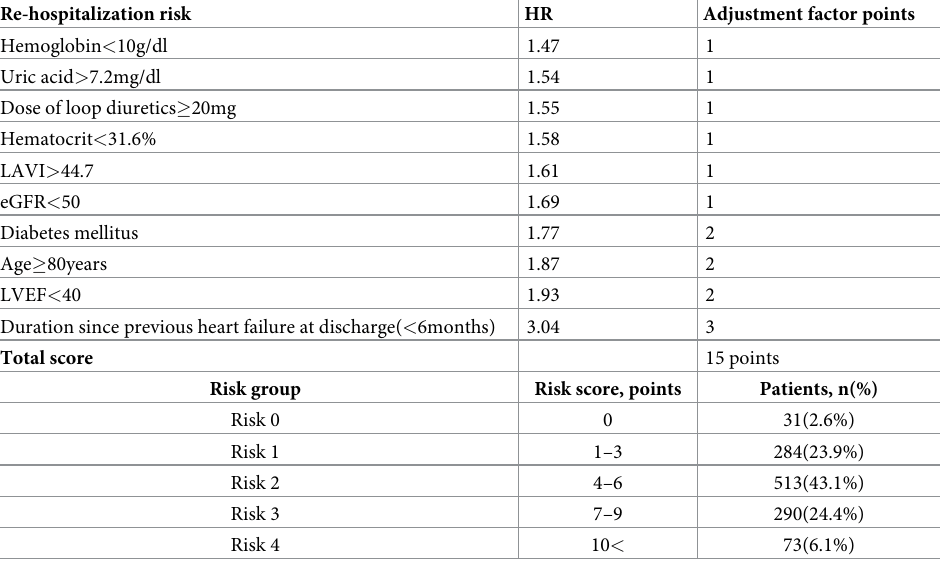
Table 3. The Pretol score.